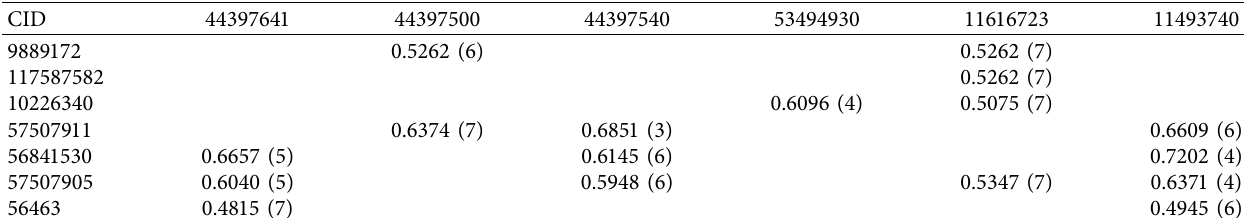
Table 7: Tanimoto coefficients for the atoms similarity in different groups of